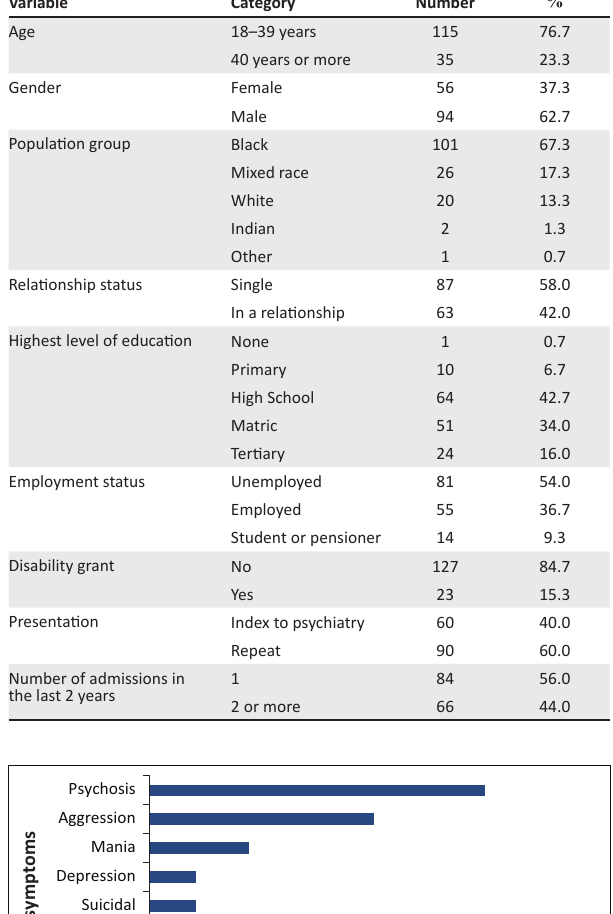
TABLE 1: Socio-demographic characteristics of the sample.